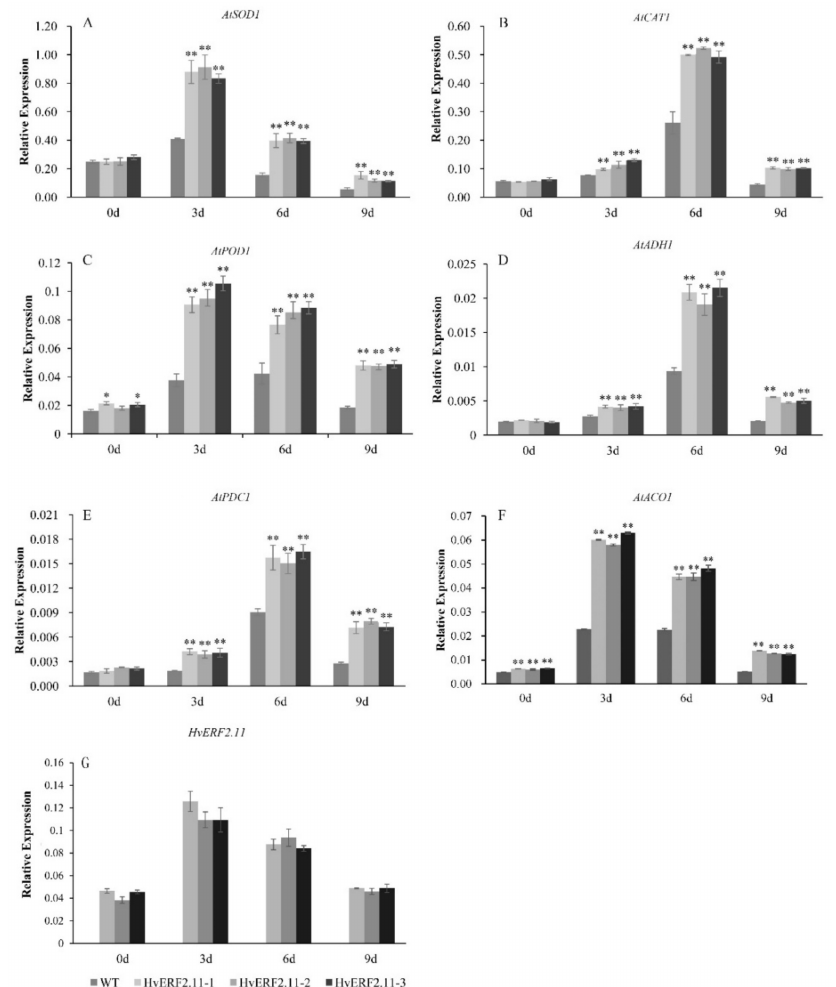
Figure 7. Expression analysis of stress-responsive genes in HvERF2.11 overexpression lines and WT under waterlogging stresses. The relative expression levels of stress-responsive genes ( AtSOD1 , AtCAT1 , AtPOD1 , AtADH1 , AtPDC1 , AtACO1 ) and HvERF2.11 were determined by qRT-PCR ( A – G ). After 3 days, 6 days, 9 days waterlogging treatments, respectively. Seedlings harvested before treatment were used as control. Relative expression levels of these six genes were normalized to the transcripts of AtActin in the same samples. The mean value and standard deviation were obtained from three independent experiments. The data represent mean ± SD of three biological repeats with three measurements per sample. Asterisks indicate significant differences between transgenic plants and WT according to Student’s t-test (* p < 0.05; ** p <